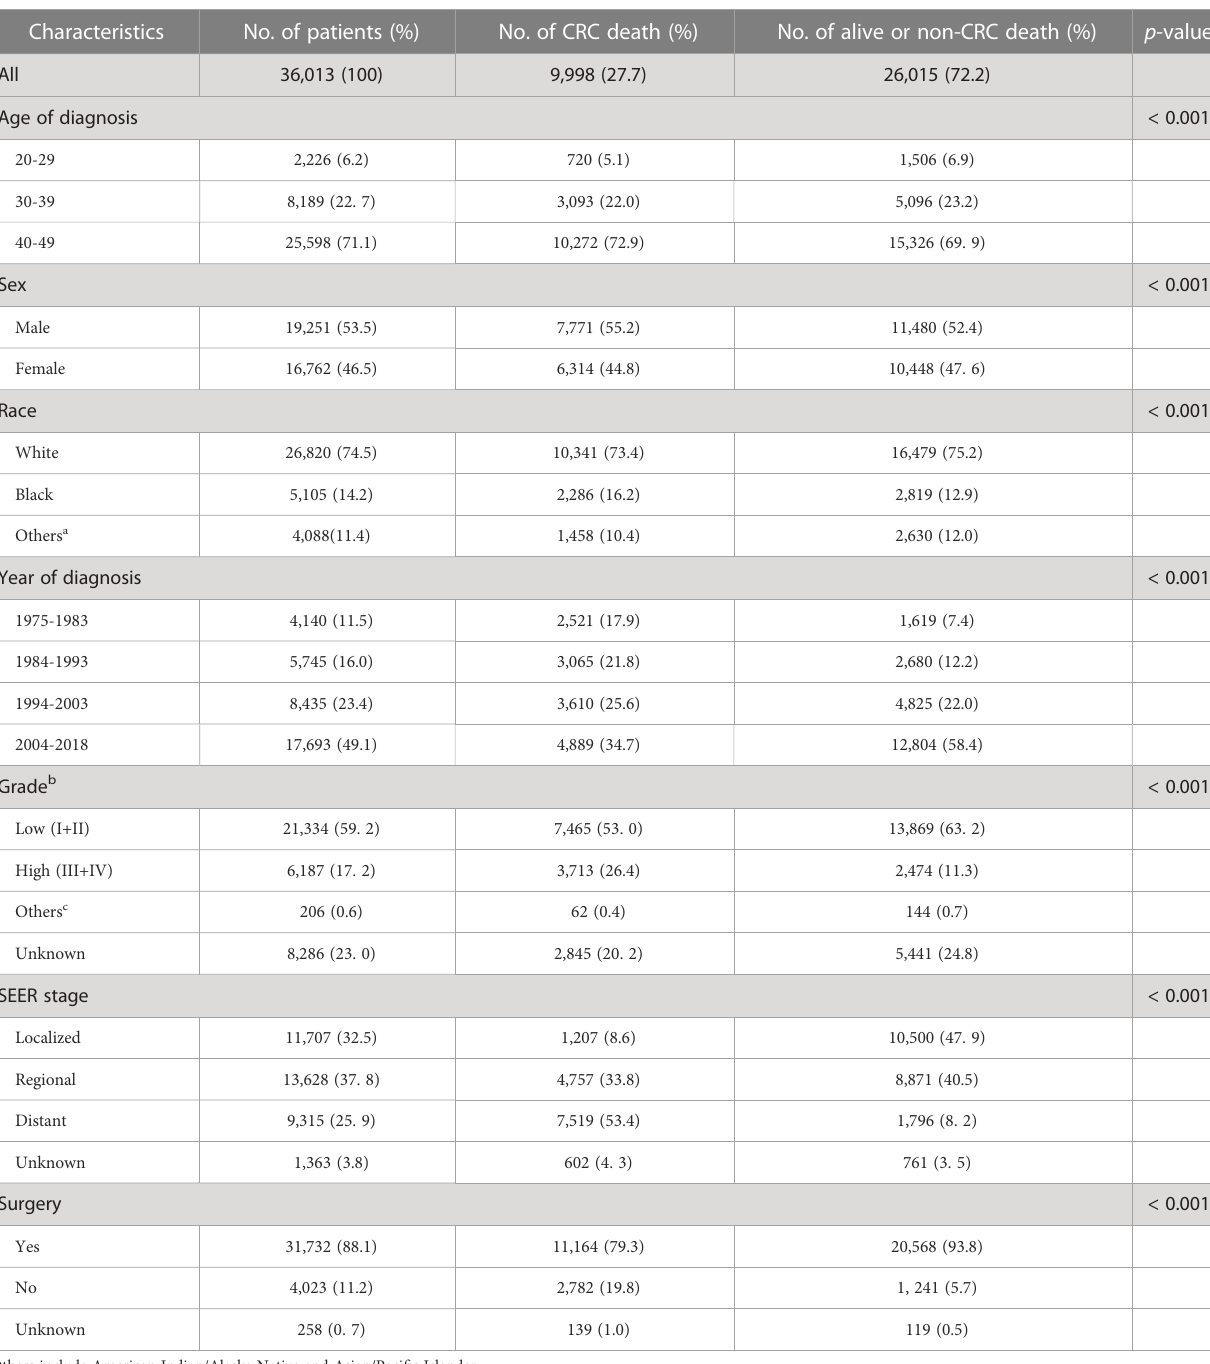
TABLE 1 Baseline characteristics of early-onset colorectal cancer population.